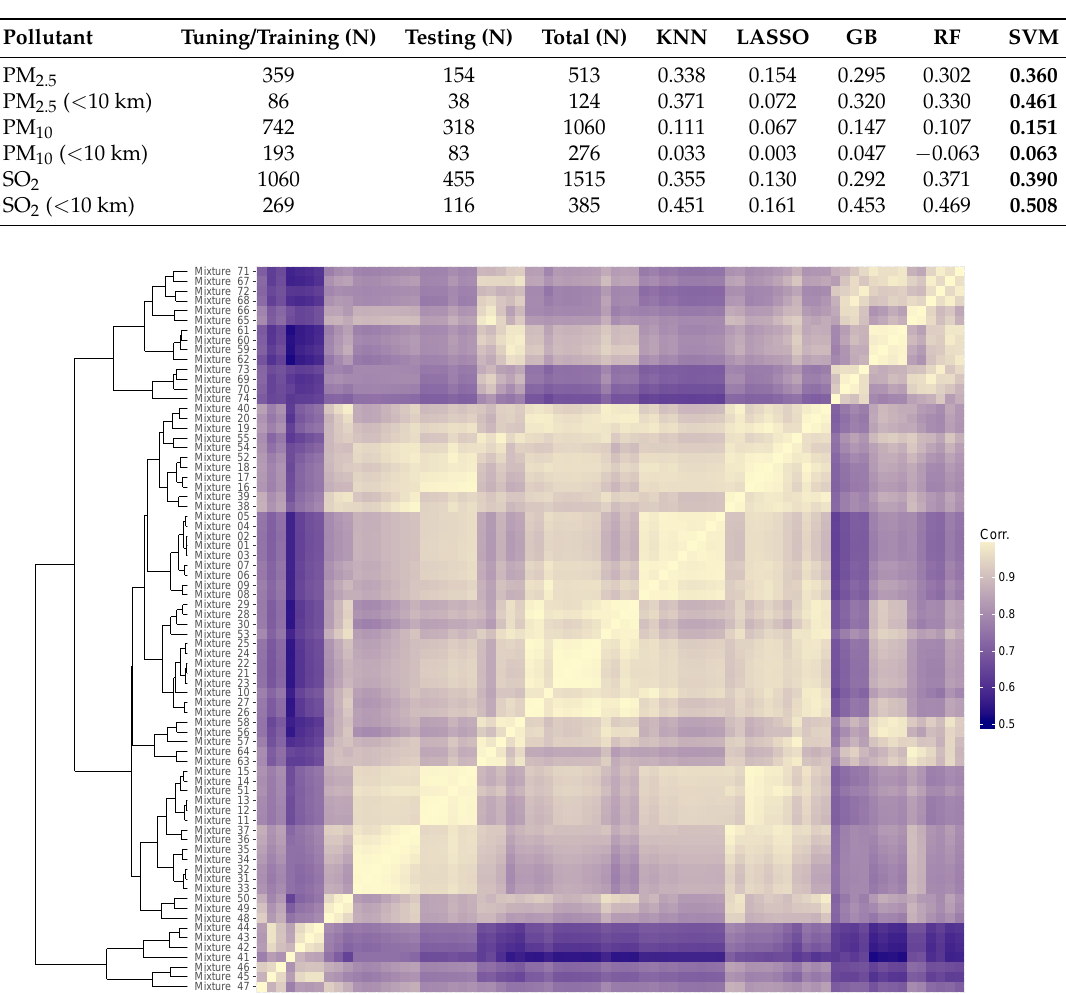
Figure 4. Correlation heatmap of 74 MISR mixtures ordered based on a hierarchical cluster tree. The x-axis has the same ordering as the y-axis, starting with Mixture